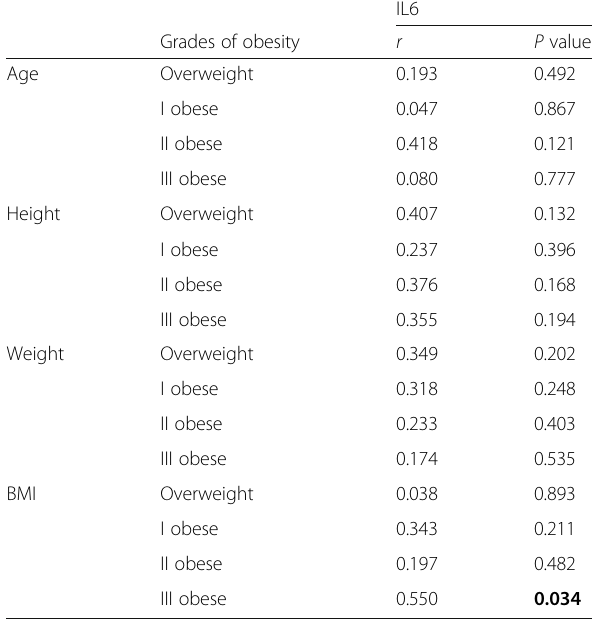
Table 6 Correlation of circulating levels of IL6 to age serum lipids in subjects with overweight and different grades of IL6